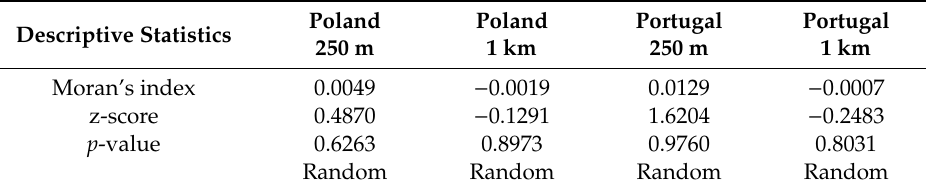
Table 4. Moran I statistics.